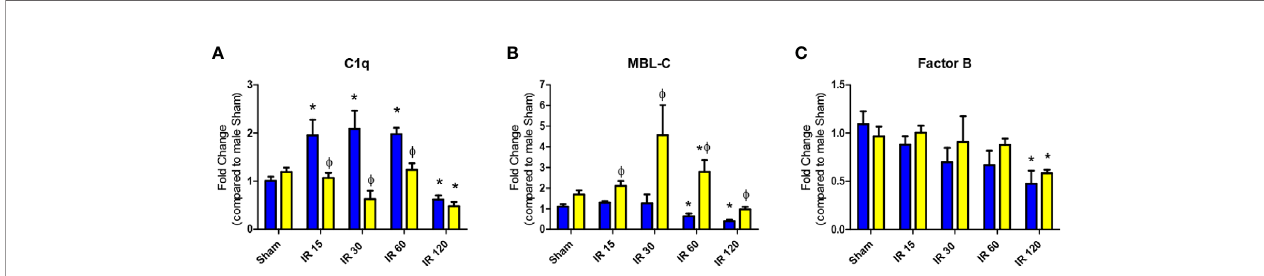
FIGURE 1 | Intestinal IR-induced complement initiation transcription differs between sexes. C57B6L/J mice were subjected to Sham and IR treatment with 15, 30, 60, or 120 min reperfusion. Mid-jejunum of (A) C1q, (B) MBL-C, and (C) Factor B, RNA expression was determined by RT-PCR analysis. Samples were normalized to 18S followed by fold change compared to Sham treatment. *, indicates signi fi cant difference between IR treatment and Sham within the same sex (P ≤ 0.05), as determined by 1-way ANOVA followed by Newman Keuls post-hoc test; Ф , indicates signi fi cant difference between sexes in the same time point and same treatment (P ≤ 0.05), as determined by unpaired t-test. Each bar is representative of 7-12 mice per group.